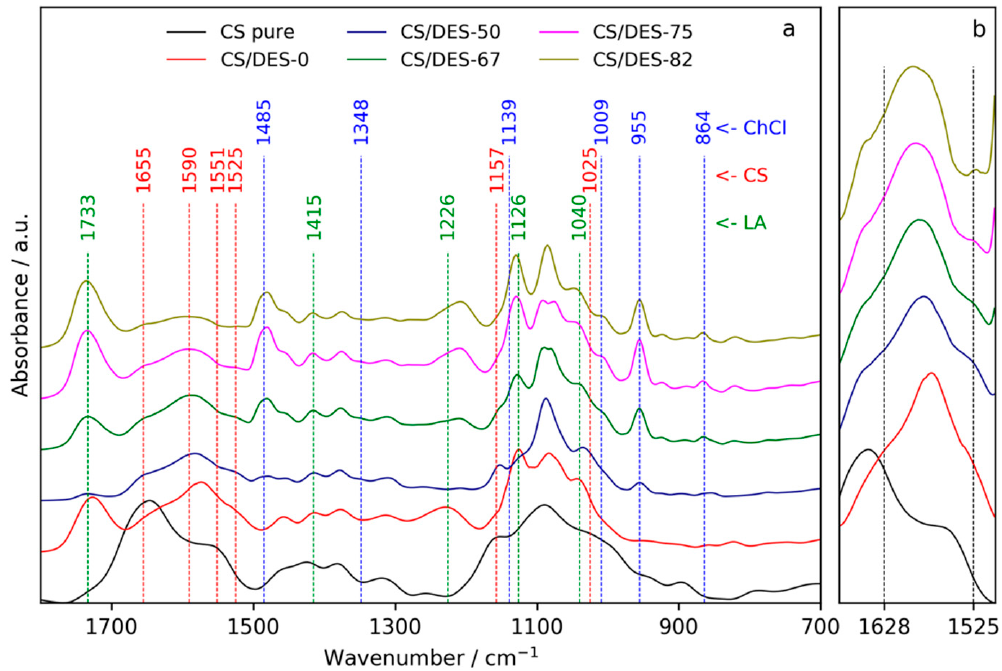
Figure 2. FTIR spectra of the pure CS, CS-LA film (CS / DES-0) and films with di ff erent NADES contents (50, 67, 75 and 82 wt%) in the regions cm − 1 1800–700 ( a ) and 1680–1500 cm − 1 ( b ). It can be noticed, that in the case of CS / DES-50 film, the peak corresponding to the –COOH − 1 groups (1733 cm ) is not observed, which is not the case for samples with higher NADES content. Disappearance of this band from a carboxylic acid FTIR spectrum takes place in the case of deprotonation − of the acid resulting in formation of carboxylate (–COO ) group. Taking into account that the content of LA is minimal in CS / DES-50 sample in comparison with the other films, it can be supposed, that in CS / DES-50 film the most part of LA is connected with CS via salt bonding. This hampers the interaction between ChCl and LA. ChCl-LA interactions are enhanced with an increase in the NADES content in − 1 the film up to 67 wt% and more. The shifting of band near 1226 cm , which is a characteristic feature − 1 of LA in the CS / DES-0 film, toward lower wavenumbers (1207 cm ) in the films with the addition of DES > 50 wt%. The same shifting of this acid related peak was observed in the case of the formation